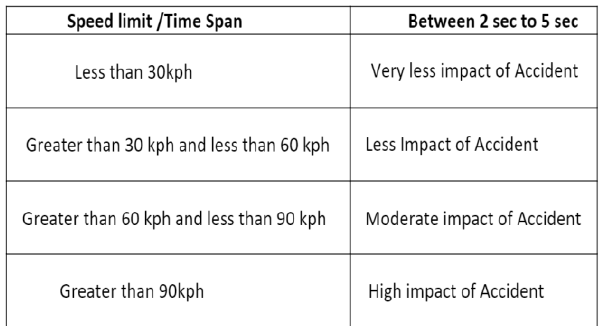
Table 3. Clusters are classified into four parts on the basis of the speed limit.